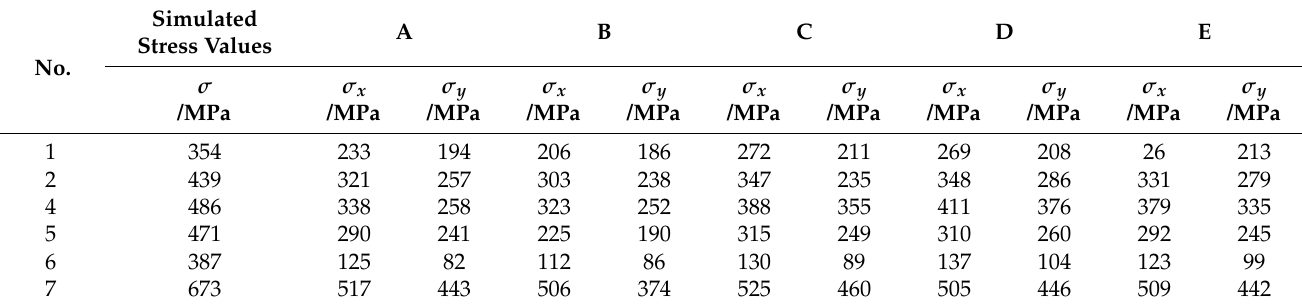
Table 4. Presumed value of residual